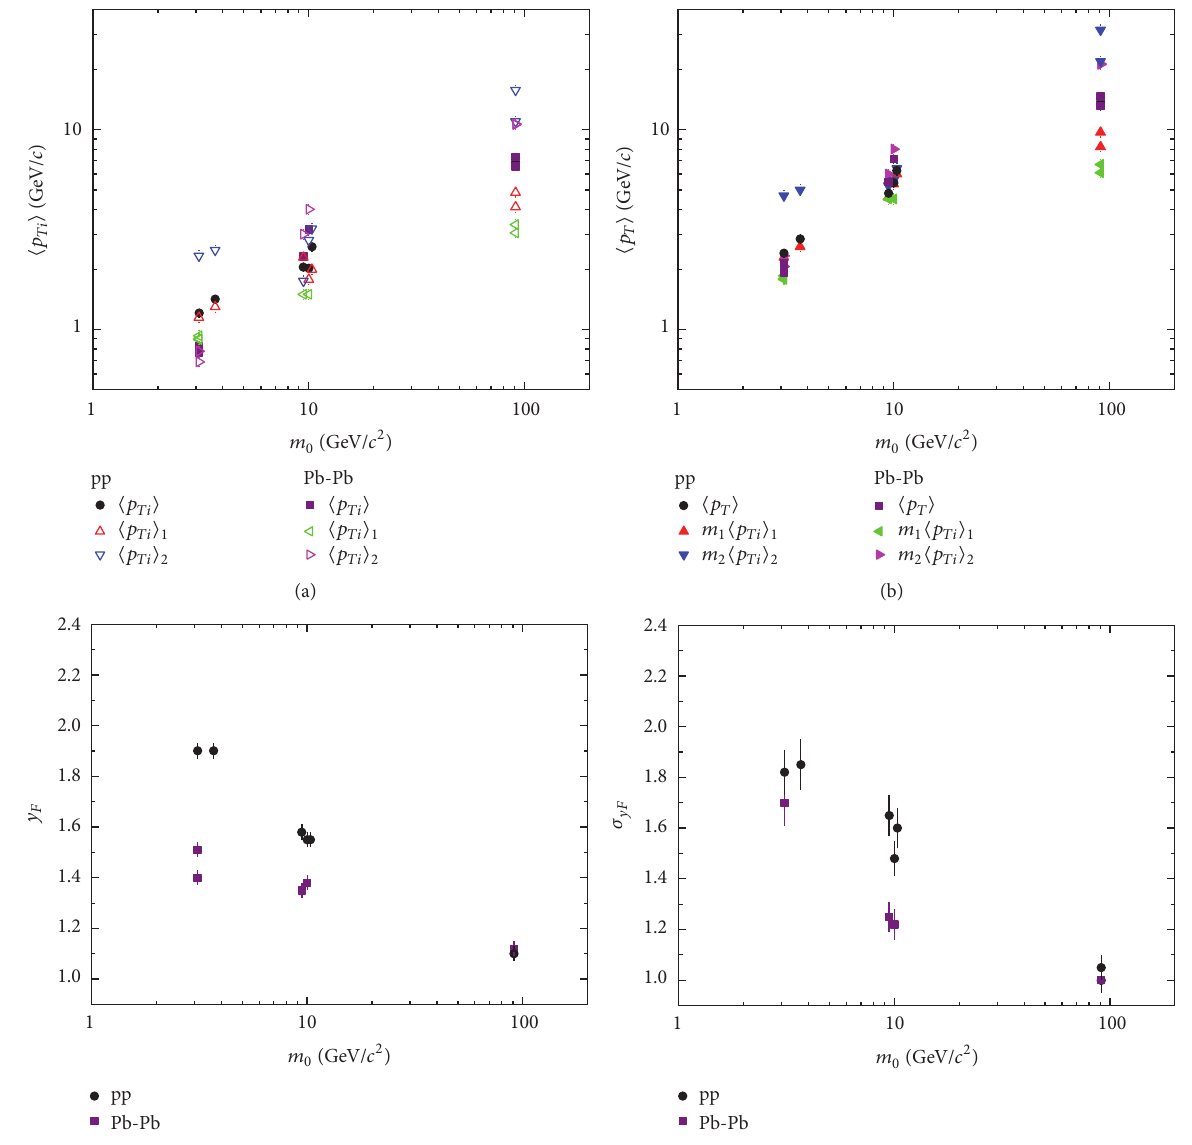
Figure 14: Relations between (a) ⟨𝑝 𝑇𝑖 ⟩ ( ⟨𝑝 𝑇𝑖 ⟩ 1 , ⟨𝑝 𝑇𝑖 ⟩ 2 ) and 𝑚 0 , (b) ⟨𝑝 𝑇 ⟩ ( 𝑚 1 ⟨𝑝 𝑇𝑖 ⟩ 1 , 𝑚 2 ⟨𝑝 𝑇𝑖 ⟩ 2 ) and 𝑚 0 , (c) 𝑦 𝐹 and 𝑚 0 , and (d) 𝜎 𝑦𝐹 and 𝑚 0 , in pp and Pb-Pb collisions. Different symbols represent different parameters for different collisions shown in the panels, where ⟨𝑝 𝑇𝑖 ⟩ , ⟨𝑝 𝑇𝑖 ⟩ 1 , and ⟨𝑝 𝑇𝑖 ⟩ 2 denote the source’s mean contributions in the first + second, first, and second components, respectively; and ⟨𝑝 𝑇 ⟩ , 𝑚 1 ⟨𝑝 𝑇𝑖 ⟩ 1 , and ⟨𝑝 ⟩ 𝑚 2 𝑇𝑖 2 denote the mean transverse momenta contributed by the first + second, first, and second components, respectively.